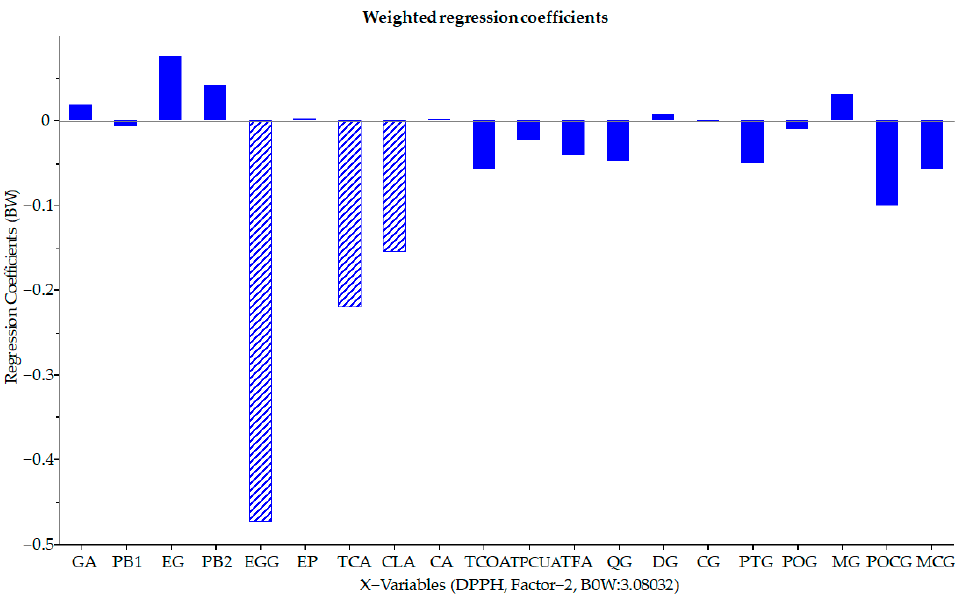
Figure 5. The weighted regression coefficients (Bw) were calculated for all the x-variables used in PLS calibration for the prediction of DPPH IC 50 ( y DPPH ) .